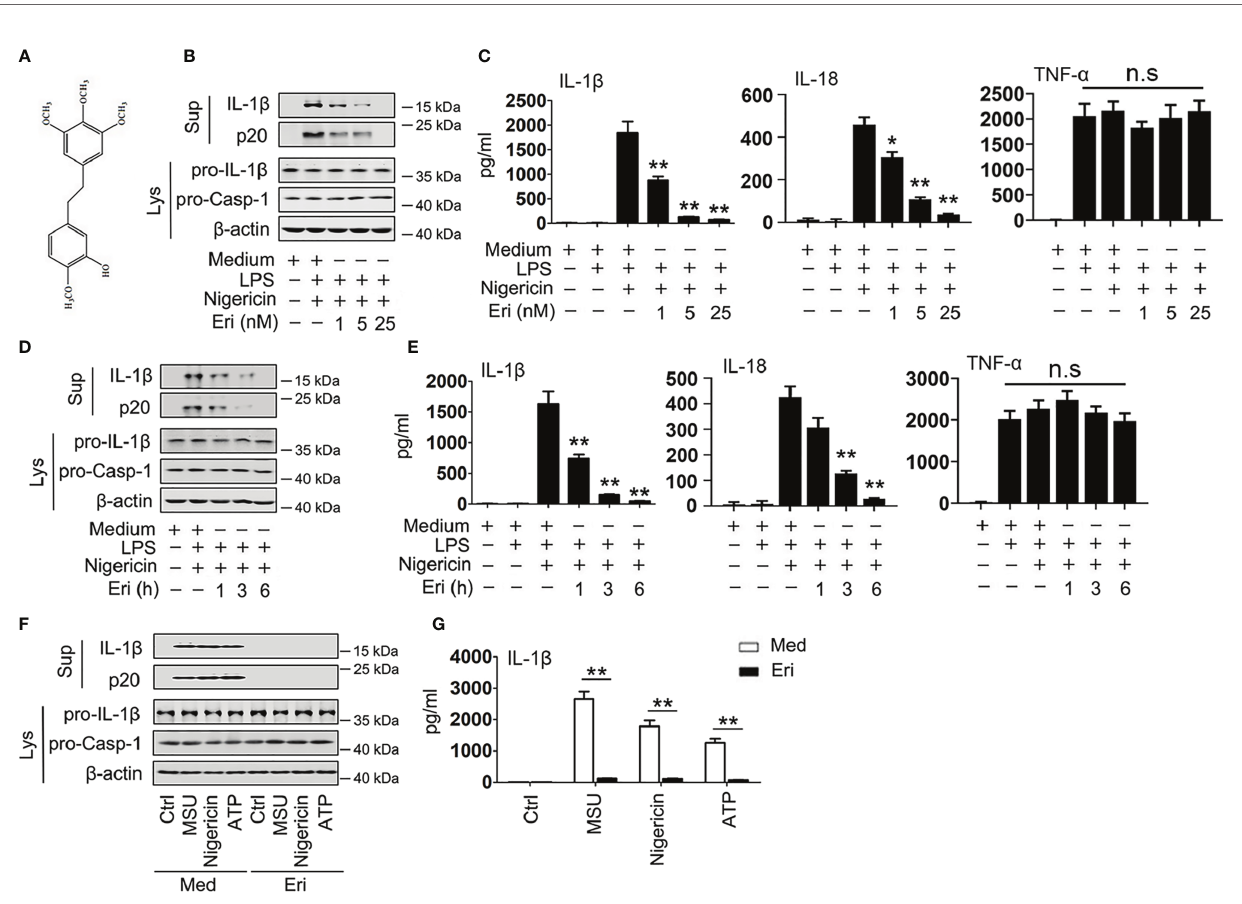
FIGURE 1 | Eri inhibits NLRP3 activation in vitro. (A) The structure of Eri. (B) BMDMs were treated with or without LPS (1 µg/ml) for 3 h, and then treated with nigericin (2 m M) and the indicated concentrations of Eri for 3 h. Mature IL-1 b and p20 in supernatants or pro-IL-1 b and pro-Casp-1 in lysates were determined by western blot. (C) BMDMs were treated with or without LPS (1 µg/ml) for 3 h, and then treated with nigericin (2 m M) and the indicated concentrations of Eri for 3 h. IL-1 b , IL-18 and TNF- a protein levels were determined by ELISA. (D, E) Experiments were performed as described in (B, C) , except that BMDMs were treated with Eri (5 nM) for indicated times. (F) BMDMs were treated LPS (1 µg/ml for 3 h), MSU (150 µg/ml for 1 h), nigericin (2 m M for 30 min) or ATP (2.5 mM for 30 min). Then, BMDMs were treated 5 nM Eri for 3 h, mature IL-1 b and p20 in supernatants or pro-IL-1 b and pro-Casp-1 in lysates were determined by western blot. (G) Experiments were performed as described in (F) , except that IL-1 b protein levels were determined by ELISA. All experiments were repeated at least three times. Bar graphs present means ± SD (**P < 0.01; *P < 0.05). n.s., not signi fi